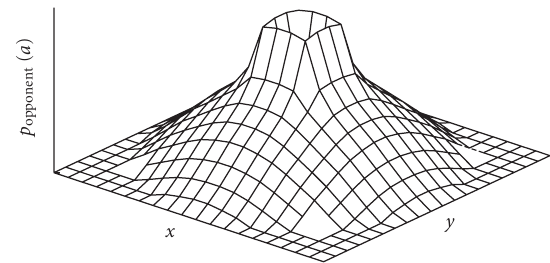
Figure 4: The potential p opponent ( a ) generated by the opponent that is in the